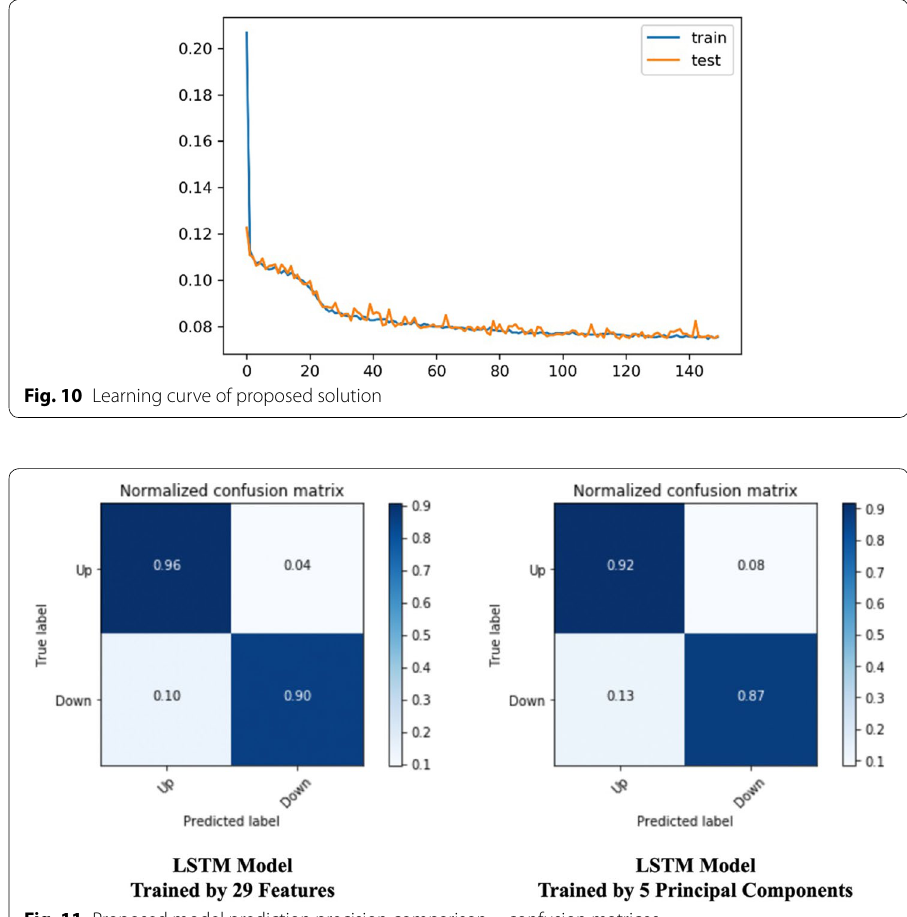
Fig. 11 Proposed model prediction precision comparison—confusion